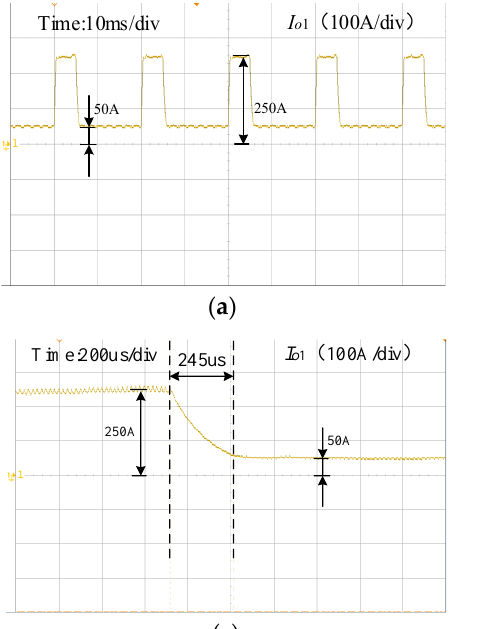
Figure 17. Large current and small current response waveform. ( a ) Large current and small current ( b ) Small current rises to large current ( c ) Large current drops to small current.